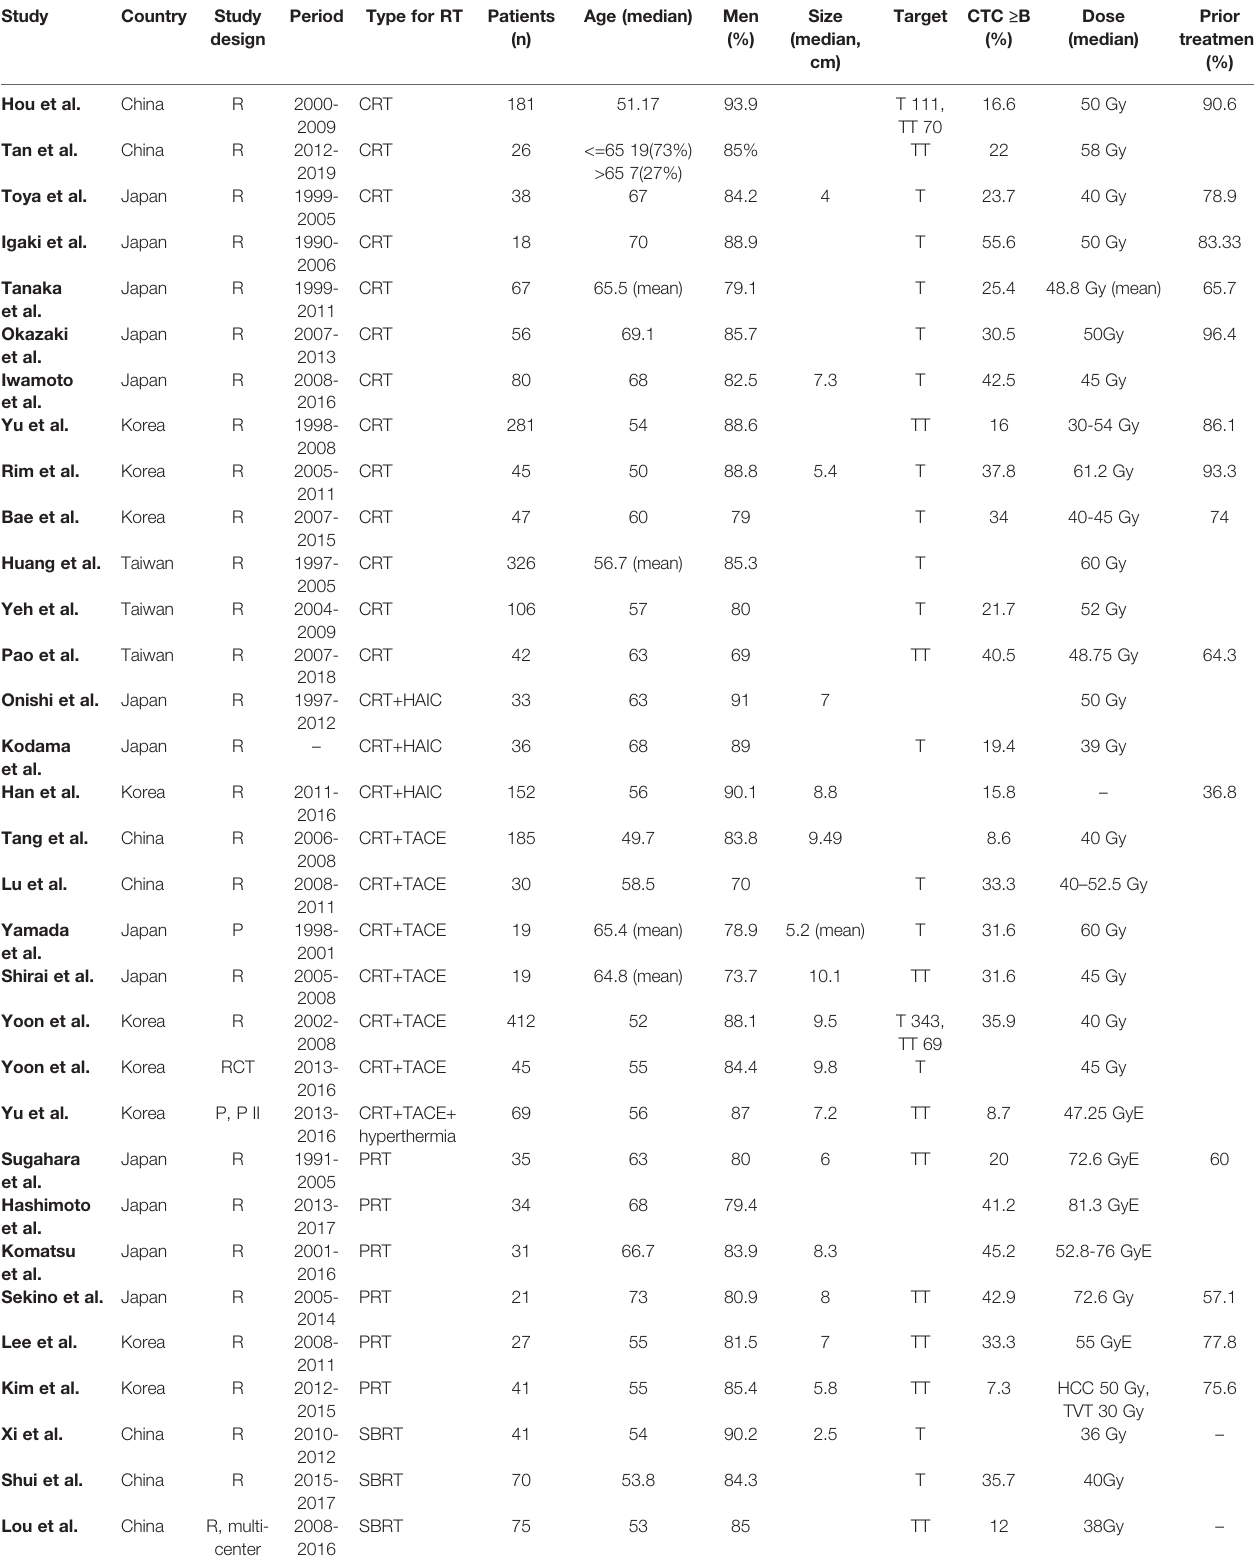
TABLE 1 | Characteristics of the included studies.